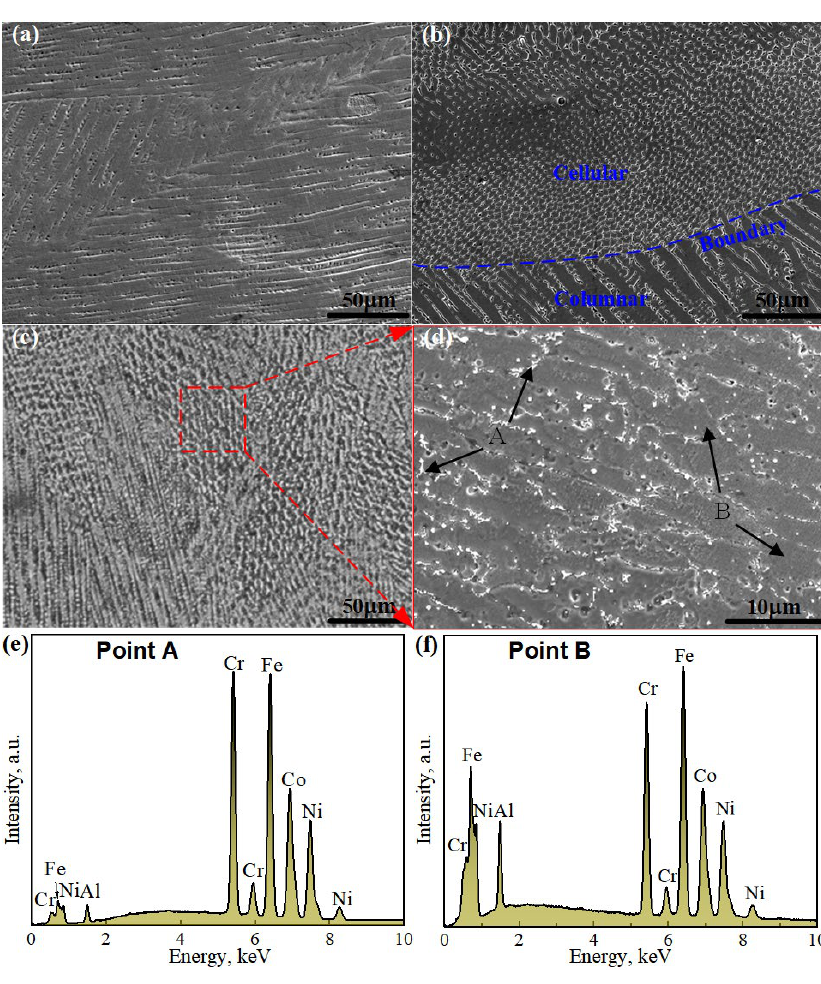
Figure 5. SEM images of cross-sections of single cladding tracks of ( a ) FeCoCrNi, ( b ) FeCoCrNiAl 0.5 , ( c , d ) FeCoCrNiAl, ( e , f ) EDS of points A and B indicated in Figure ( d